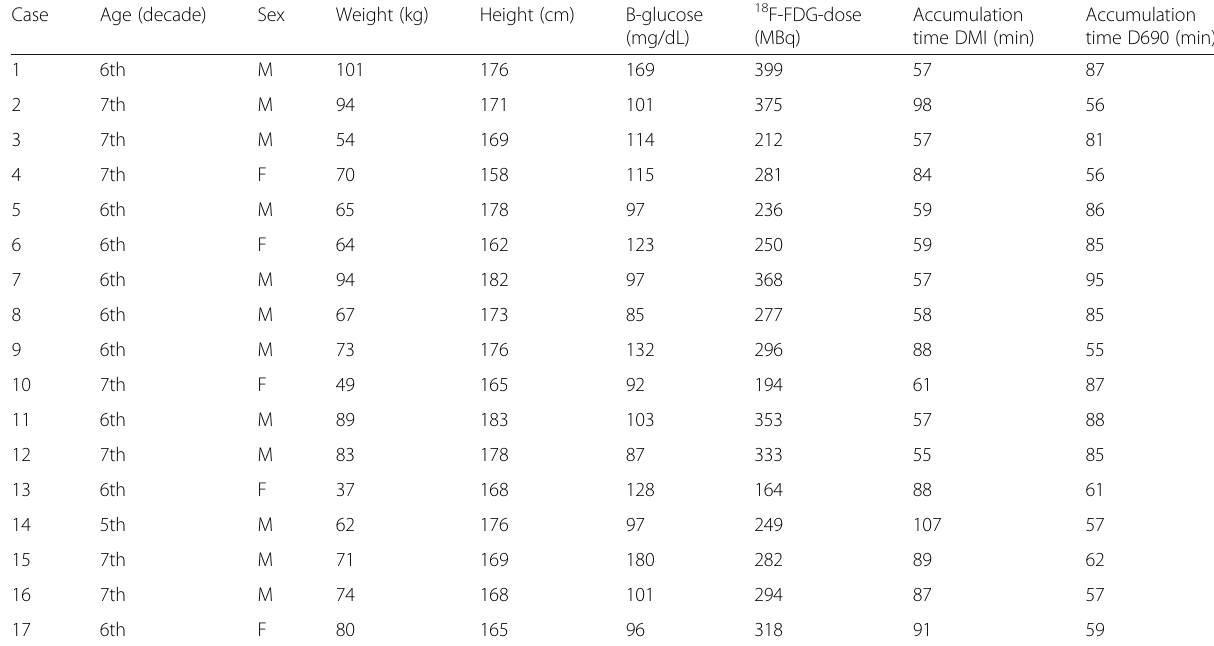
Table 1 Patient characteristics and scanning setup